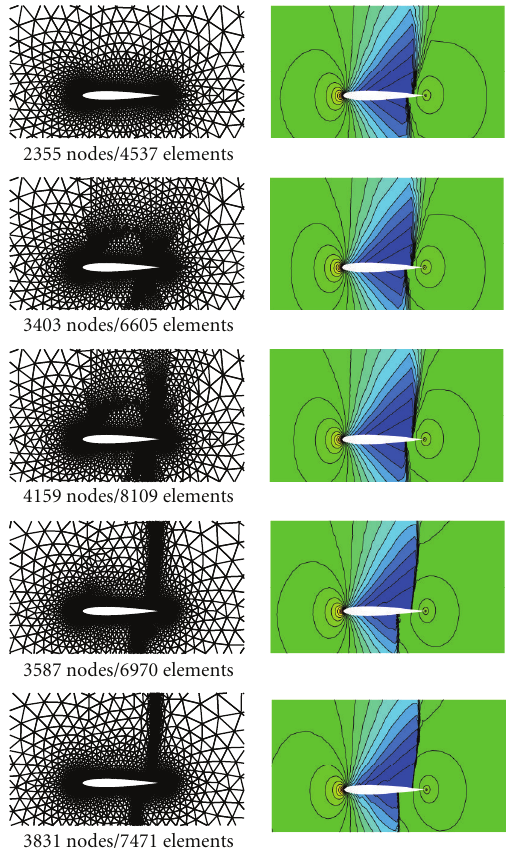
Figure 15: Evolution of the NACA0012 grid and the corresponding solution field (density) for M ∞ = 0 . 80 and α = 1 ◦